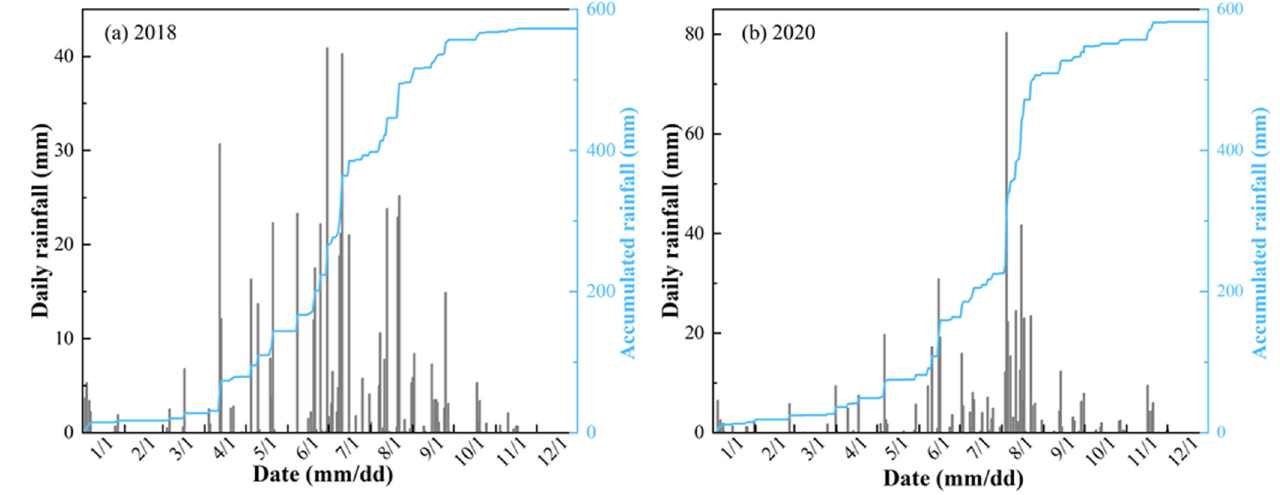
Figure 11. Daily rainfall in the Gutun watershed in 2018 ( a ) and 2020 ( b ).